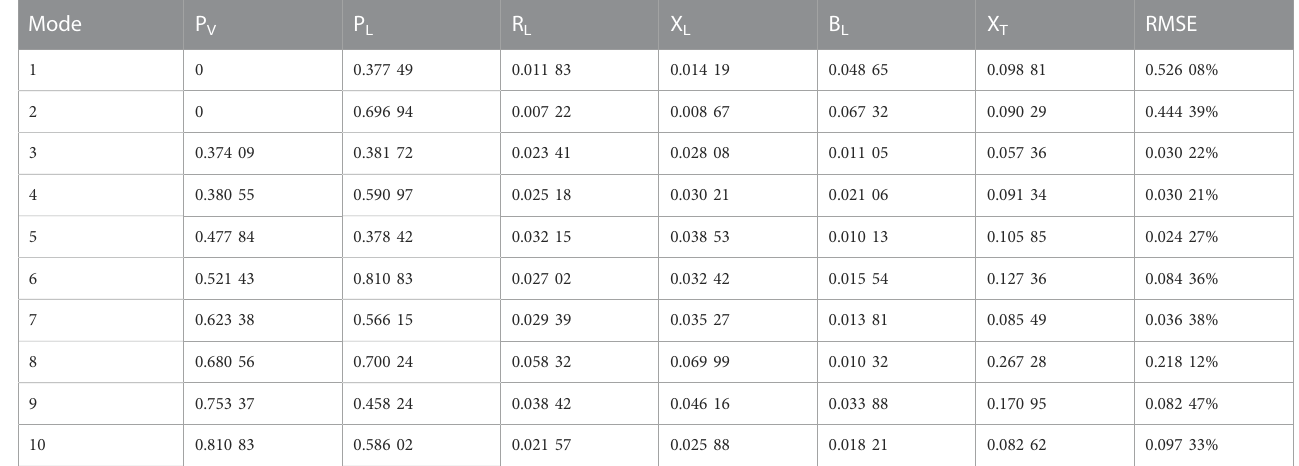
TABLE 1 The equivalent parameters under different operation modes and RMSE of network loss.